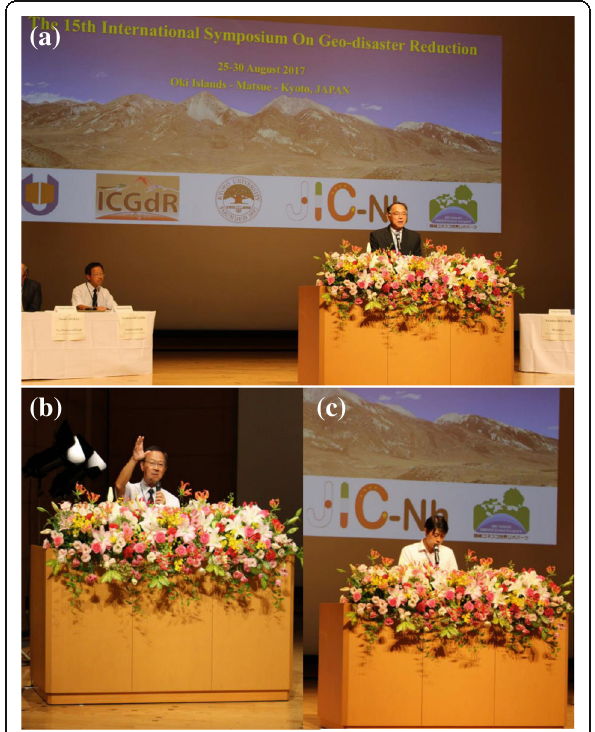
Fig. 3 Opening speech presented by ( a ) Prof. Yasunao Hattori, ( b ) Prof. Masakatsu Miyajima, ( c ) Mr. Soichiro